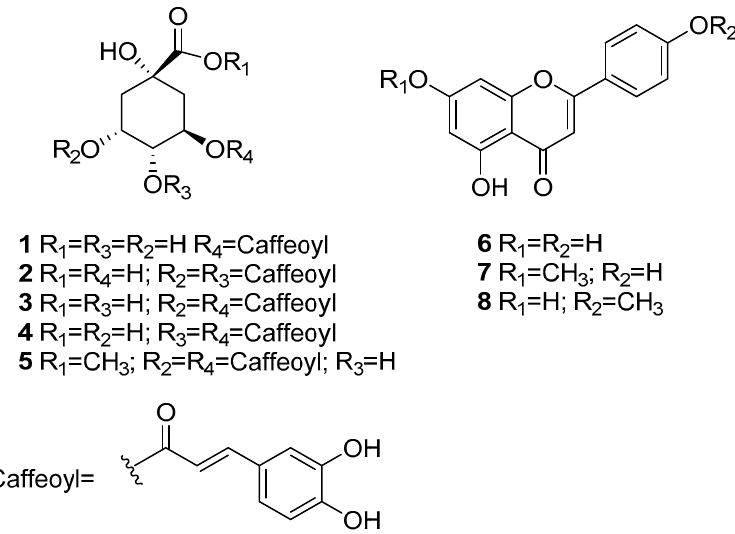
Figure 2. Compounds isolated from B. heterophylla ’s aqueous extract.